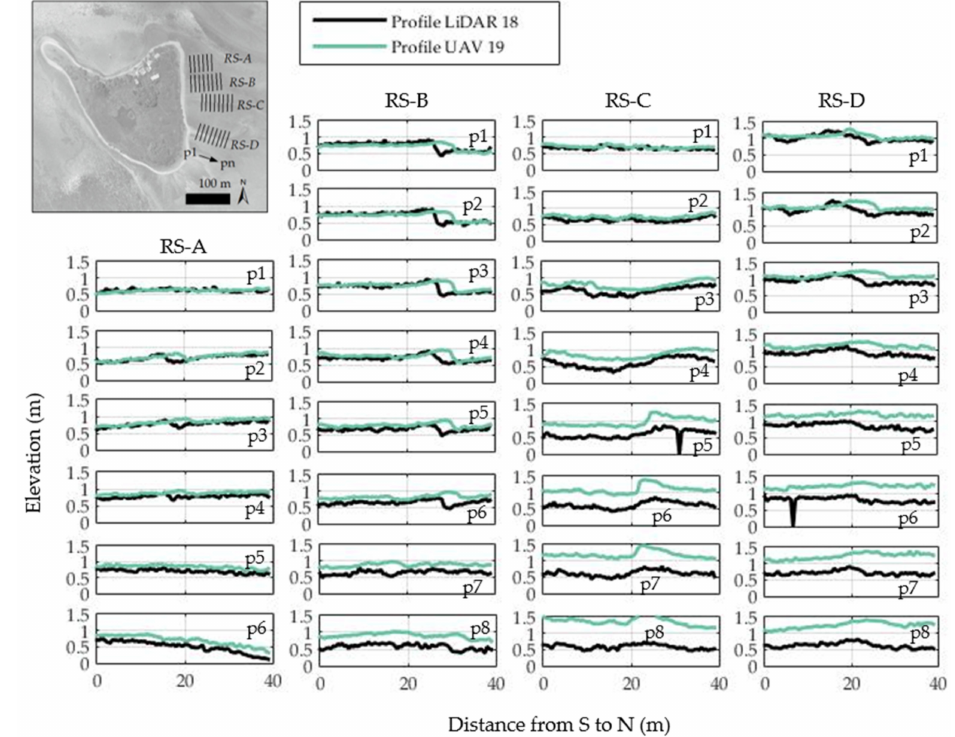
Figure 9. Dynamics of the rubble spits present at the reef flat from the 2018 LiDAR (black lines) to the 2019 RPA (green lines) datasets (see the upper left map for location). Each panel shows the cross-sectional profile of the spit at the 40 m long transects